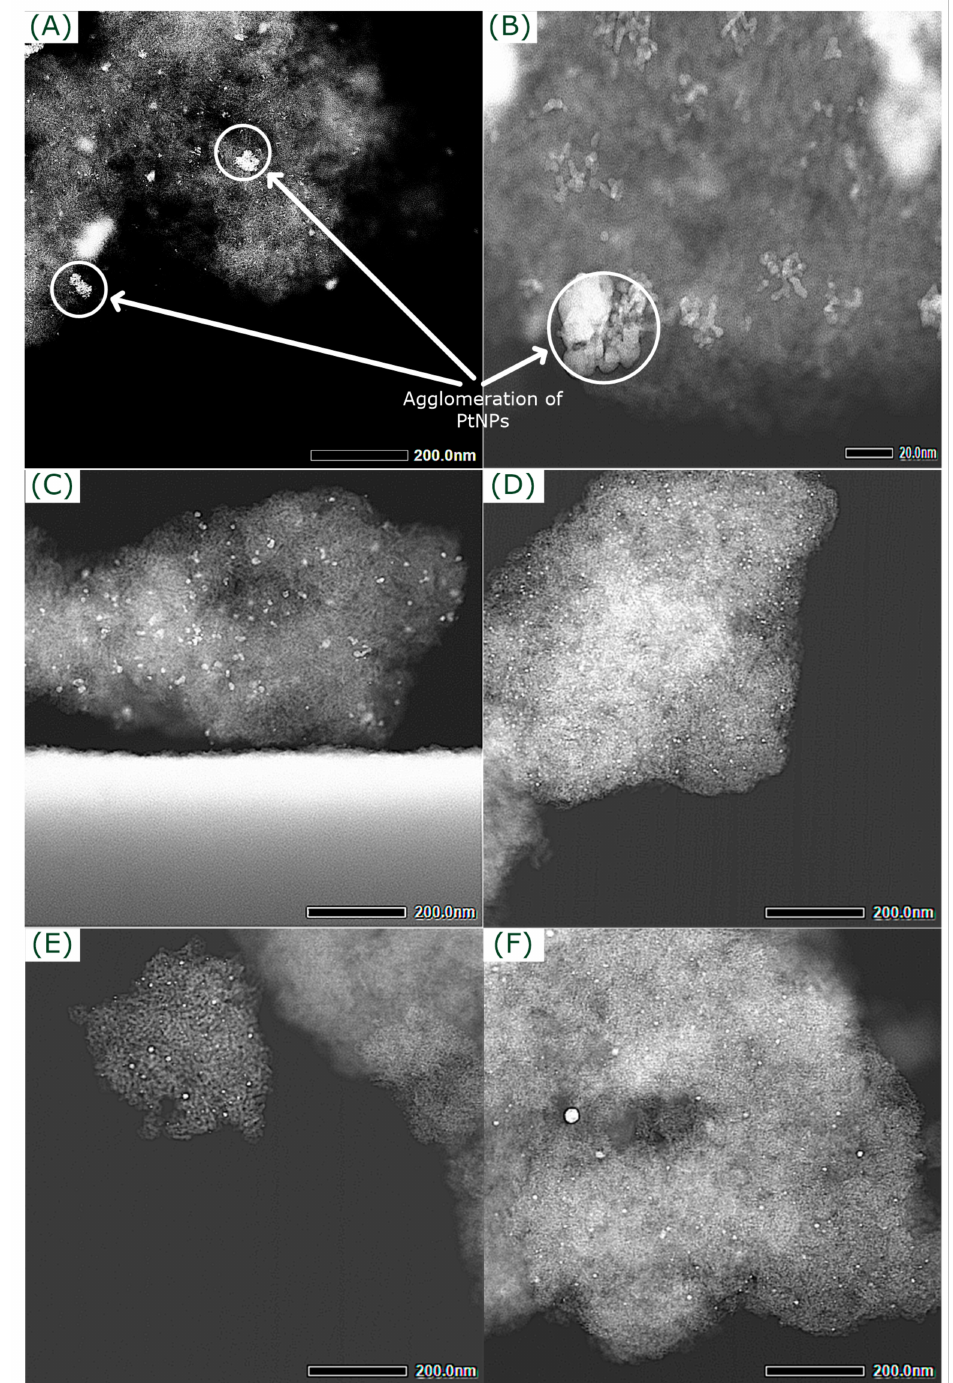
Figure 3. STEM HAADF images of prepared Pt@PC500 photocatalysts through different reducing methods: photoreduction ( A , B ) and microemulsion with ascorbic acid ( C ), clove ( D ), grape seed ( E ), and mangosteen ( F